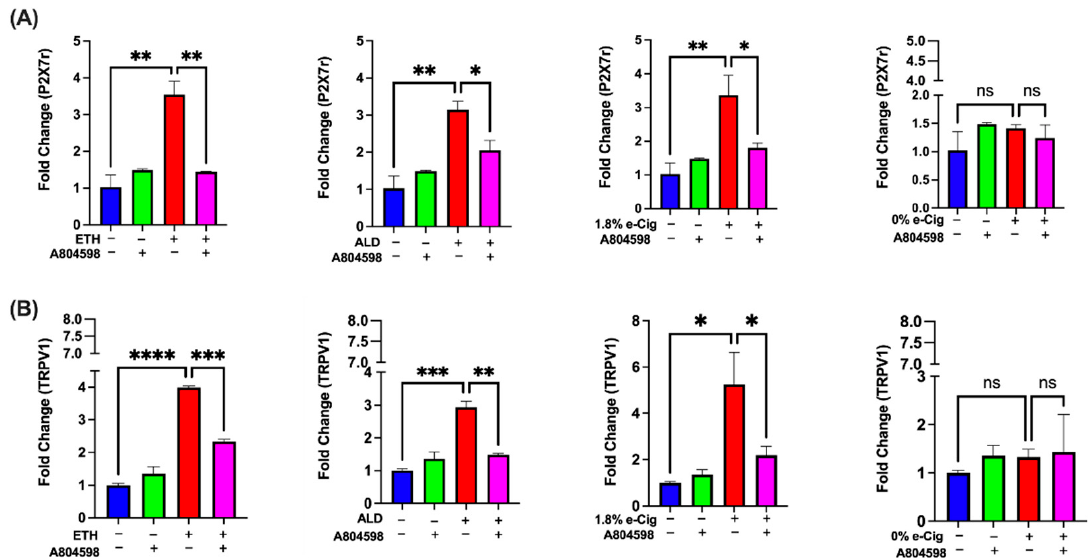
Figure 6. ETH, ALD, and 1.8% e-Cig exposure increased the gene expression of P2X7r and TRPV1 channels in hBMVECs. ( A ) hBMVECs treated with ETH, ALD, and 1.8% e-Cig exposure increased the P2X7r gene expression by four-fold while A804598 prevented such increases. ( B ) Simultaneously, expression of TRPV1 ion channel was also enhanced six-fold after exposure to ETH, ALD, or 1.8% e-Cig and A804598 treatment ameliorated the increases. q-PCR data were normalized with GAPDH ( n = 3). One-way ANOVA was used for statistical analyses, marked as * p ≤ 0.05, ** p ≤ 0.01, *** p ≤ 0.001, **** p ≤ 0.0001 and ns (not significant).